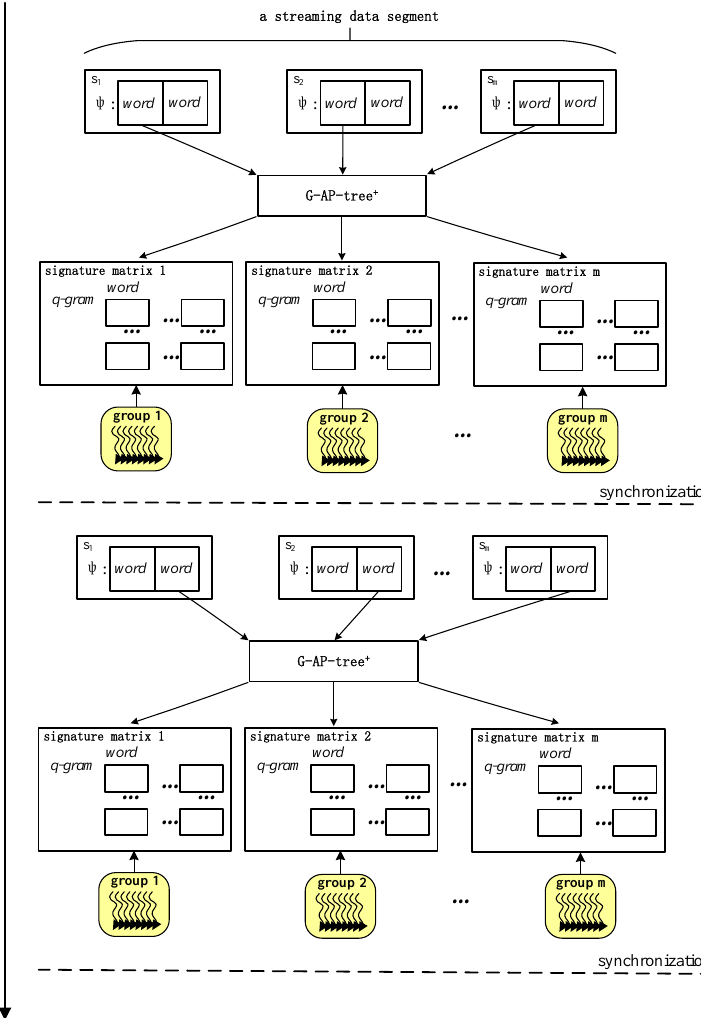
Figure 5. Illustrating the parallel scheme of approximate keyword